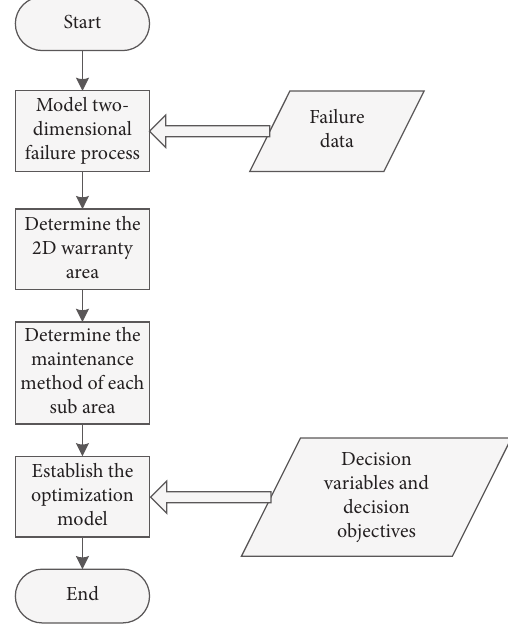
Figure 2: The 2D warranty modeling